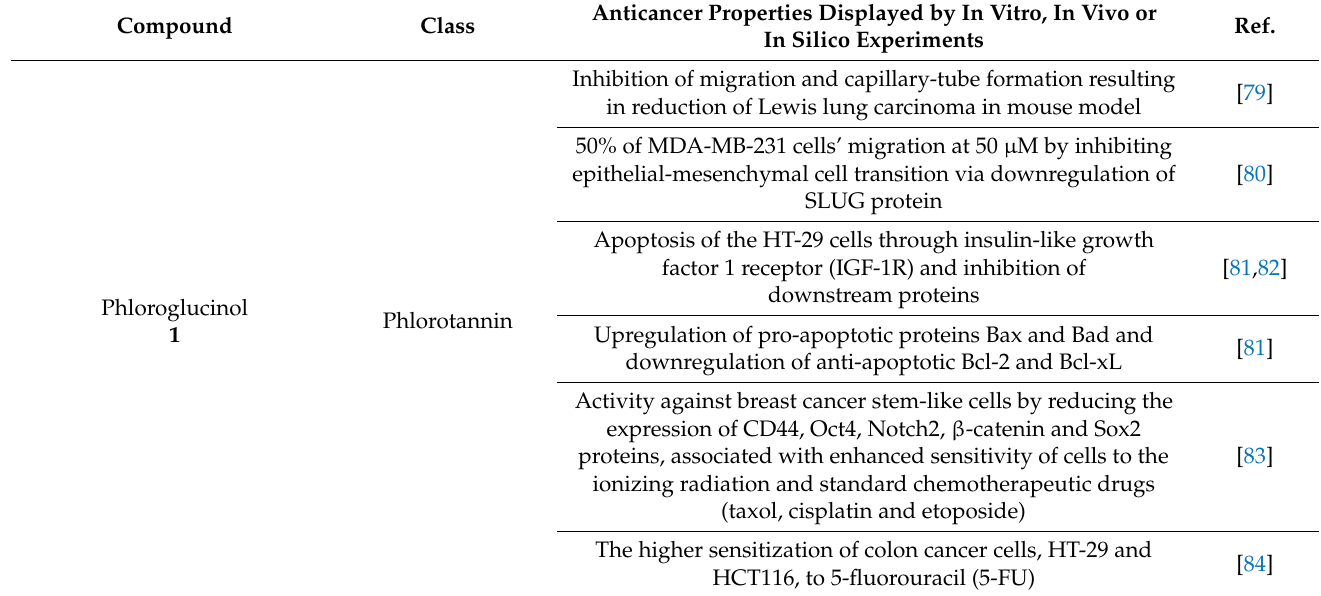
Table 1. Anticancer properties of marine-derived phenolic compounds obtained by different experi- mental systems (in vitro, in vivo or in